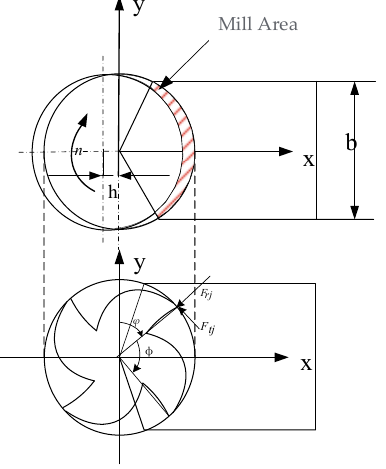
Figure 9. Diagram of Mill Area.